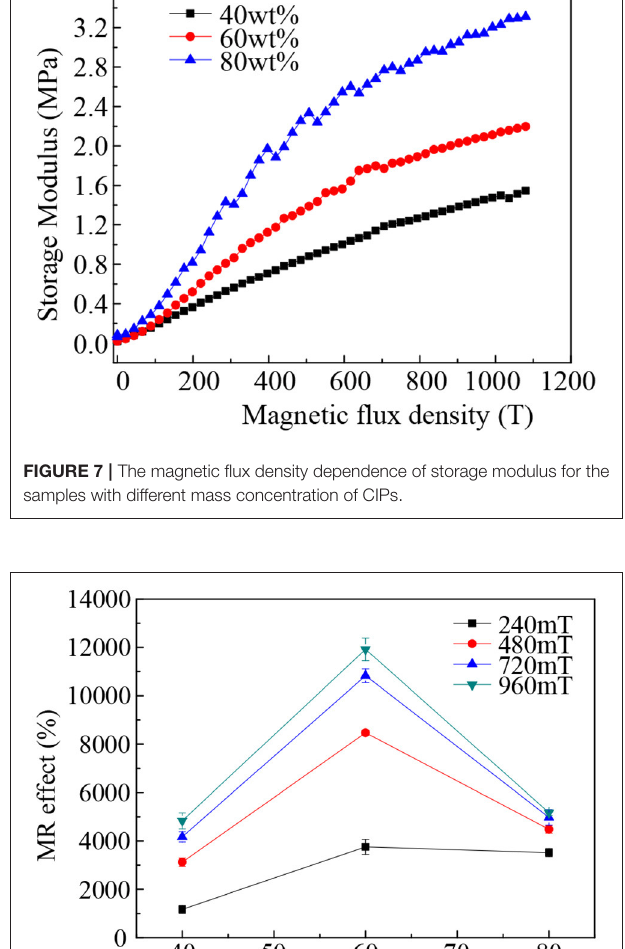
TABLE 2 | The critical strain amplitude of samples under different field. Samples